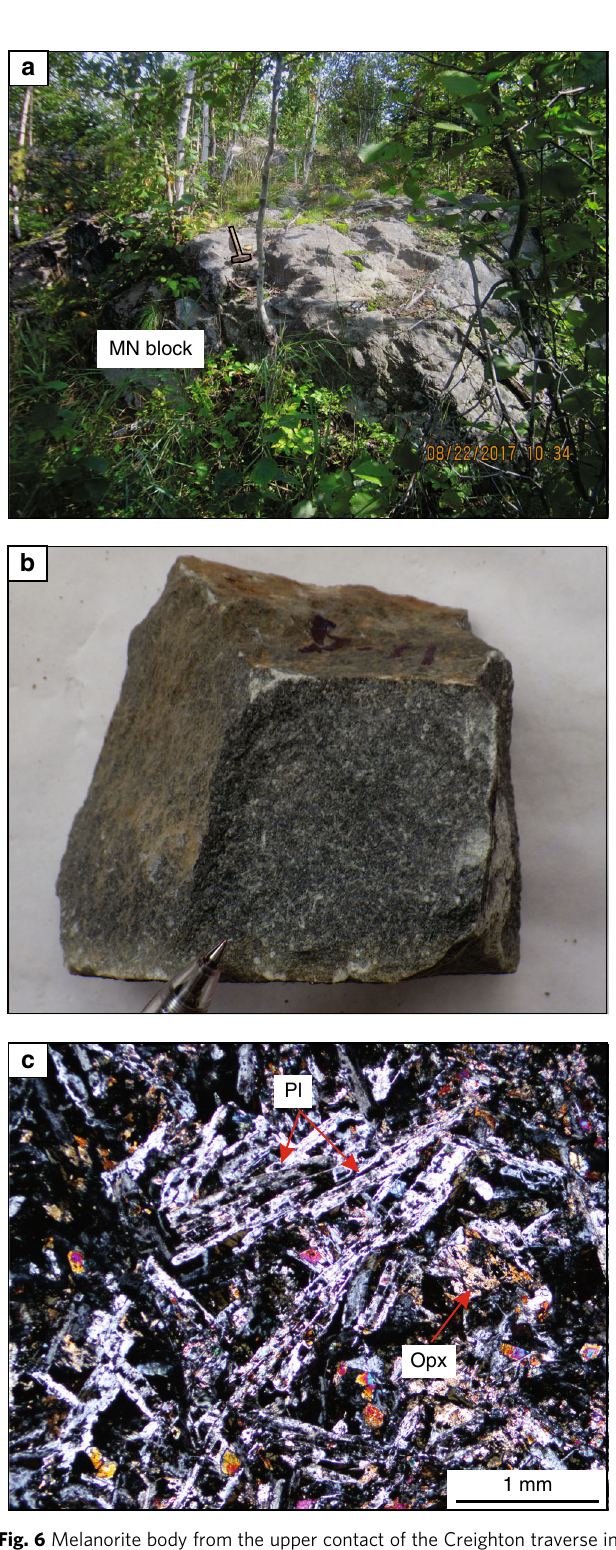
Fig. 6 Melanorite body from the upper contact of the Creighton traverse in the South Range of the SIC. a Field photograph of an outcrop of Melanorite body that occurs along the contact of the SIC with Onaping Formation. The length of the hammer used for scale is 45 cm. Photo courtesy by Walter Peredery. b Photograph of a hand specimen of melanorite. The length of pencil used for scale is 2 cm. c Photomicrograph showing variable alteration of highly elongated plagioclase and small subhedral orthopyroxene.